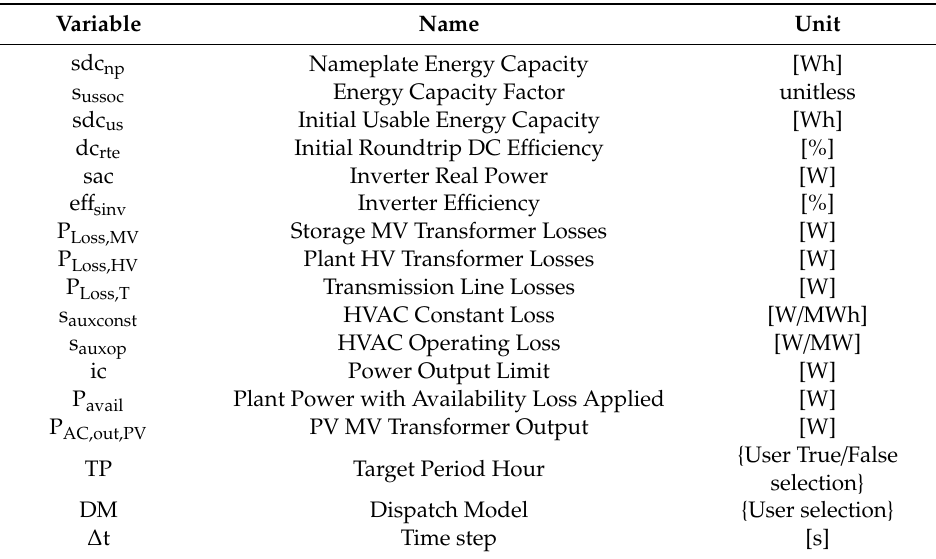
Table A4. Mathematical variables in dispatch logic in Plant Predict 1 .